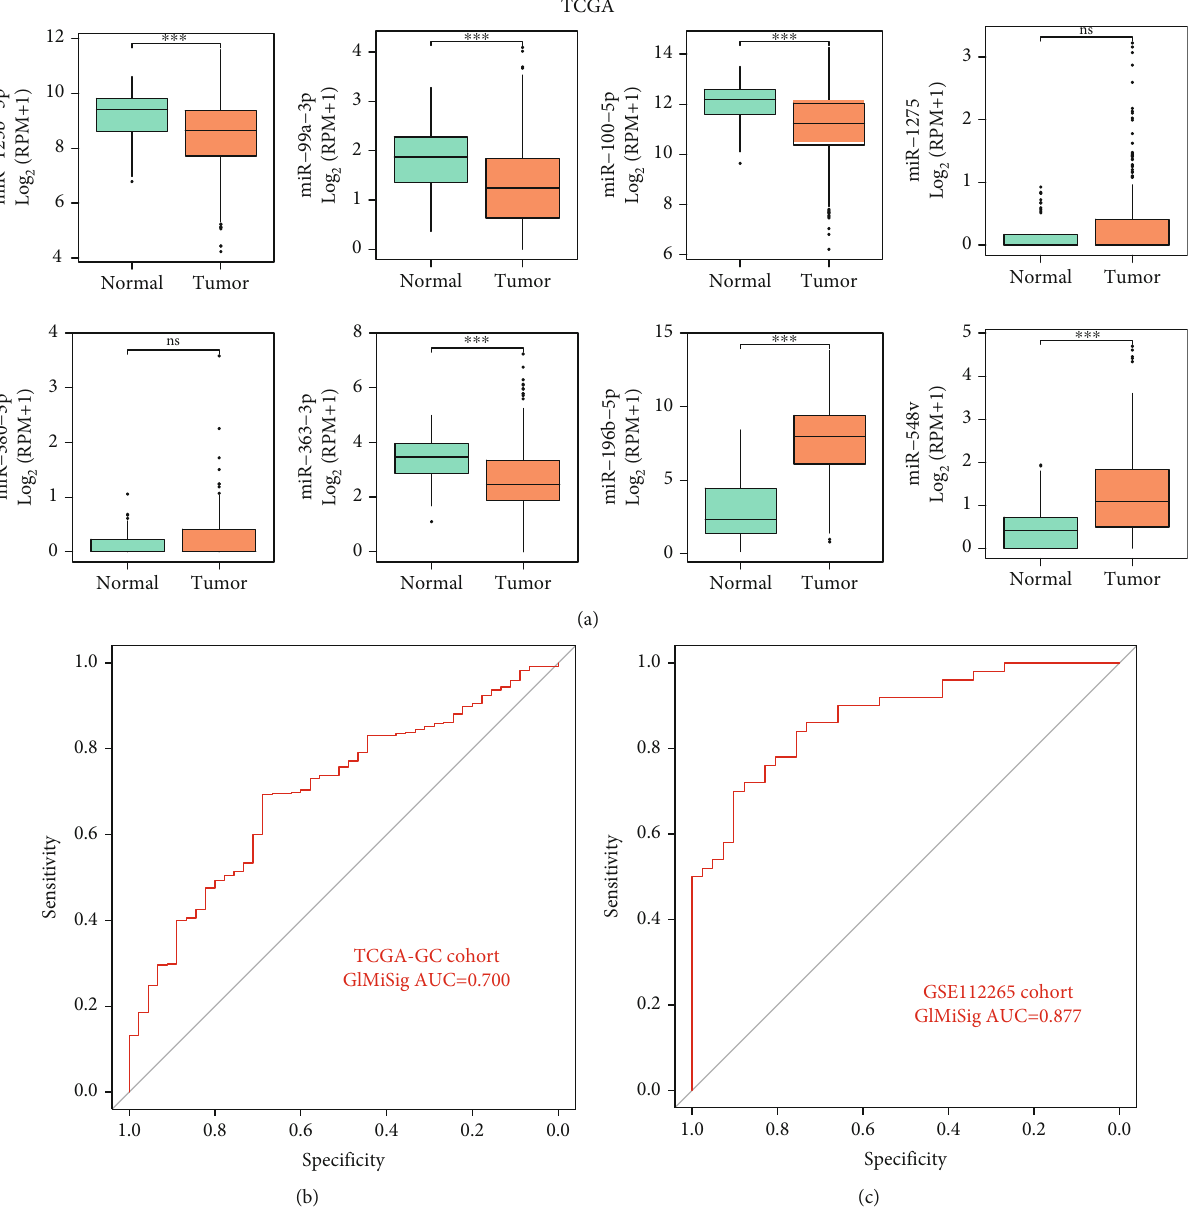
Figure 6: Diagnostic value of the GIMiSig. (a) Expression levels of the 8 miRNAs between the normal and tumor groups in TCGA. AUC values of the GIMiSig to diagnose GC patients in TCGA cohort (b) and GSE112264 cohort (c). Orange indicates the tumor group, and green indicates the normal group. ∗ p < 0 : 05 , ∗∗ p < 0 : 01 , and ∗∗∗ p < 0 : 001